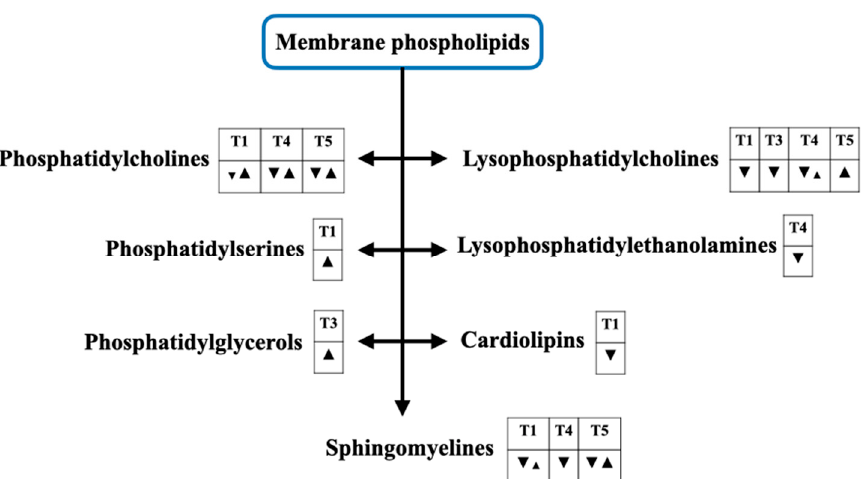
Figure 3. (Previous page) The alterations of cell membrane phospholipids for sepsis diagnosis (Table 1), septic shock diagnosis (Table 2), prognostication of sepsis (Table 3), prognostication of septic shock (Table 4), and monitoring the treat- ment response (Table 5). A down-sided triangle ( ▼ ) represents a decreased level, whereas an up-sided triangle ( ▲ ) rep- resents vice versa. Several kinds of the cell membrane phospholipids are involved in this setting. An alteration of phos-